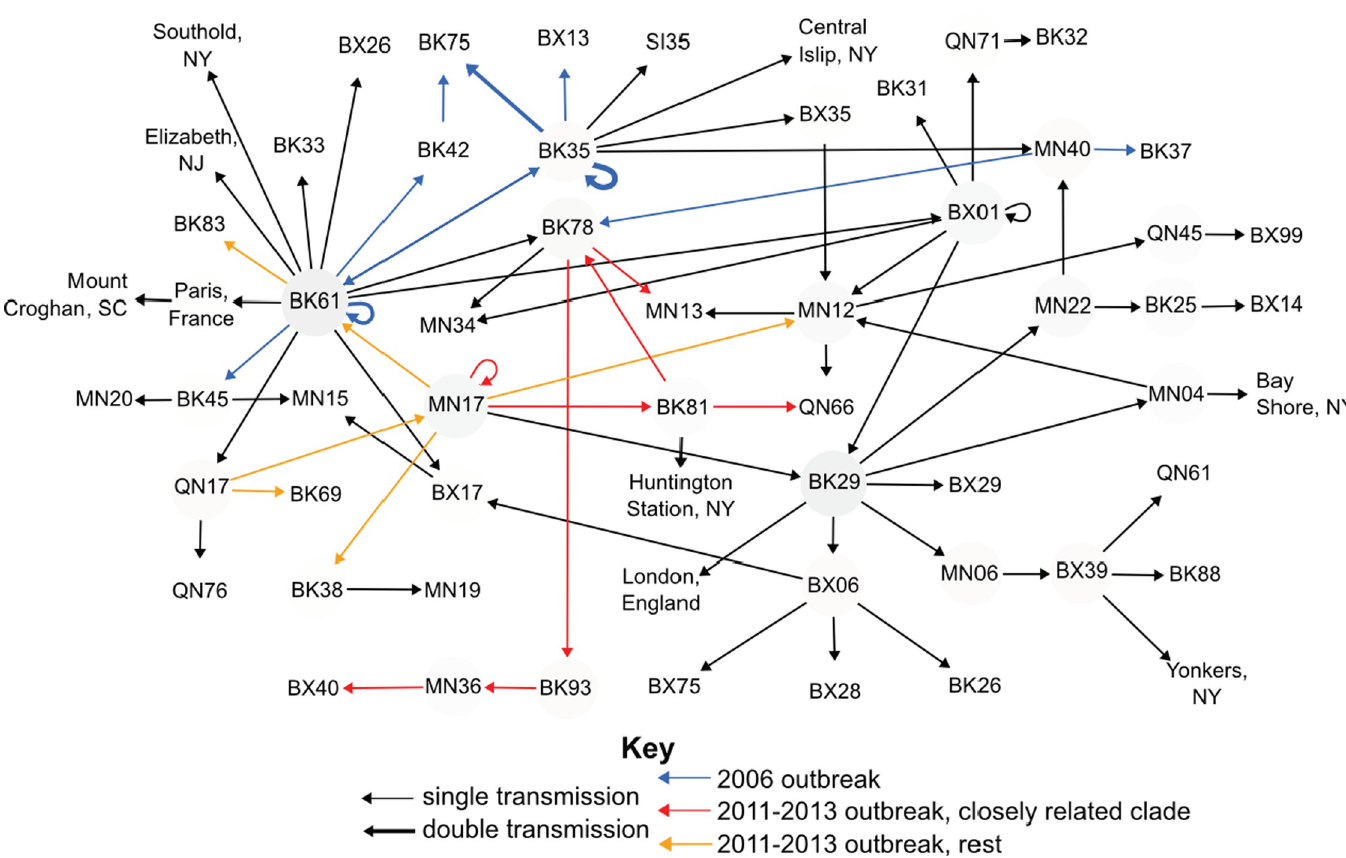
Fig 3. Betweenness and the movement of Nm around NYC neighborhoods. Locations with higher betweenness values have a darker colored circle. Most arrows represents single transmission event between neighborhoods with the 3 exceptions that have slightly thicker arrows: (1) two transmissions happened between BK35 (Stuyvesant Heights) and BK75 (Bedford), (2) two transmissions happened within BK61 (Crown Heights North), (3) three transmissions happened within BK35 (Stuyvesant Heights). Arrows colored blue represent those transmissions that were part Ob1. Ob2 is designated with arrows colored either red for the closely related subclade and orange for the rest of the outbreak isolates. The neighborhood codes are all the official designation from New York City Neighborhood Tabulation Areas. A key for those referenced is in Table A in S1 File. Those from the same borough start with the same letters; BX:Bronx, BK:Brooklyn, MN:Manhattan, SI:Staten Island, QN: